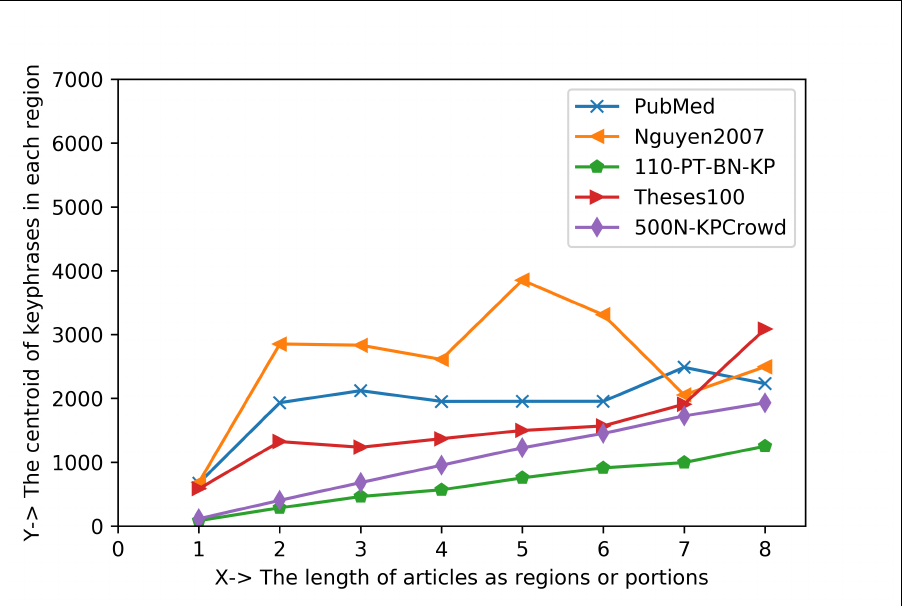
Figure 6. The analysis of keyphrase centroid using first occurrence keyphrase based on eight regions for 2nd five